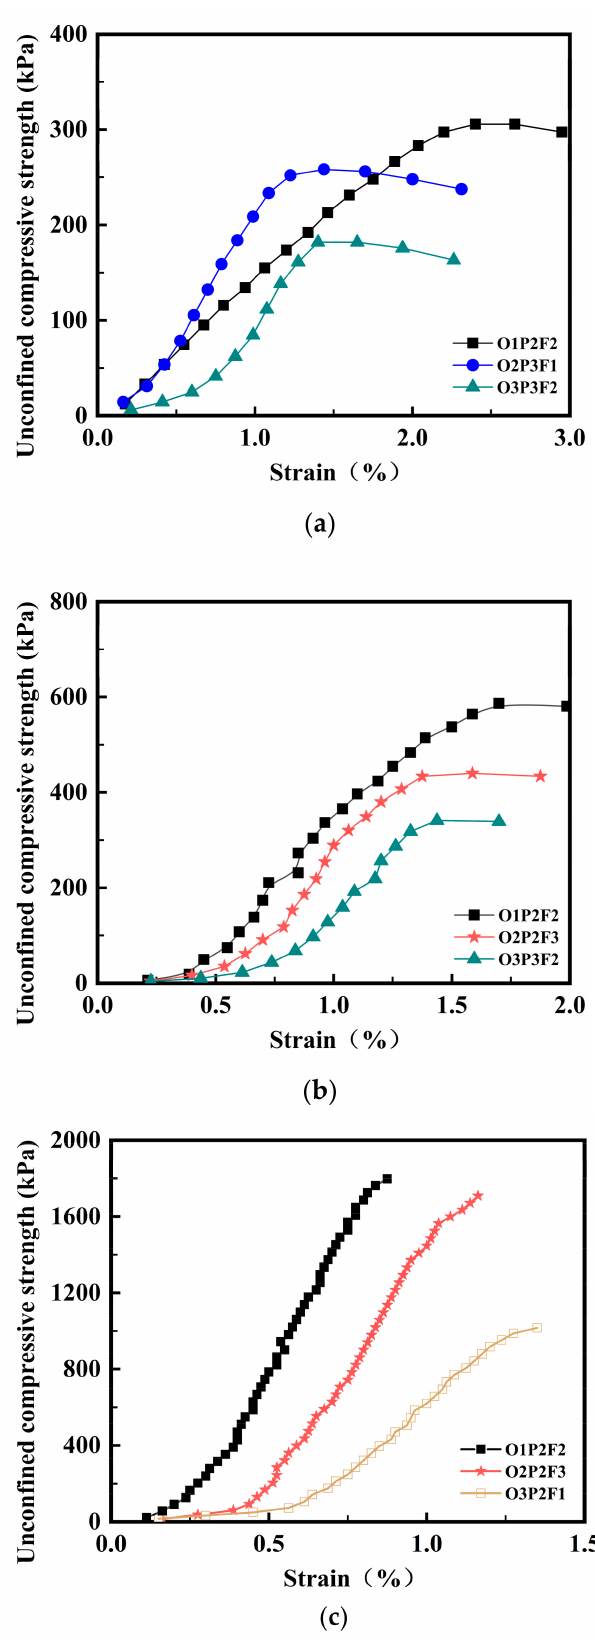
Figure 6. Stress-strain curve of solidified soil. ( a ) 3 days curing age. ( b ) 7 days curing age. ( c ) 28 days curing